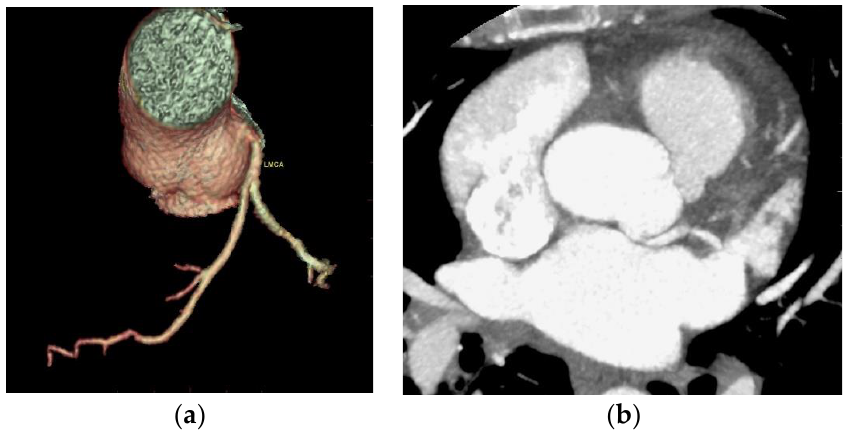
Figure 4. Acute take-off angle of the left main coronary artery. ( a ) CCTA volume rendered 3D images of the vascular tree anatomy show detachment of the left main coronary artery from the upper and posterior portion of the left coronary sinus at a sharp angle; ( b ) CCTA MIP axial contrast-enhanced image at the aortic root shows detachment of the left main coronary artery from the left coronary sinus at a sharp angle with the presence of posterior contact with the left atrium.